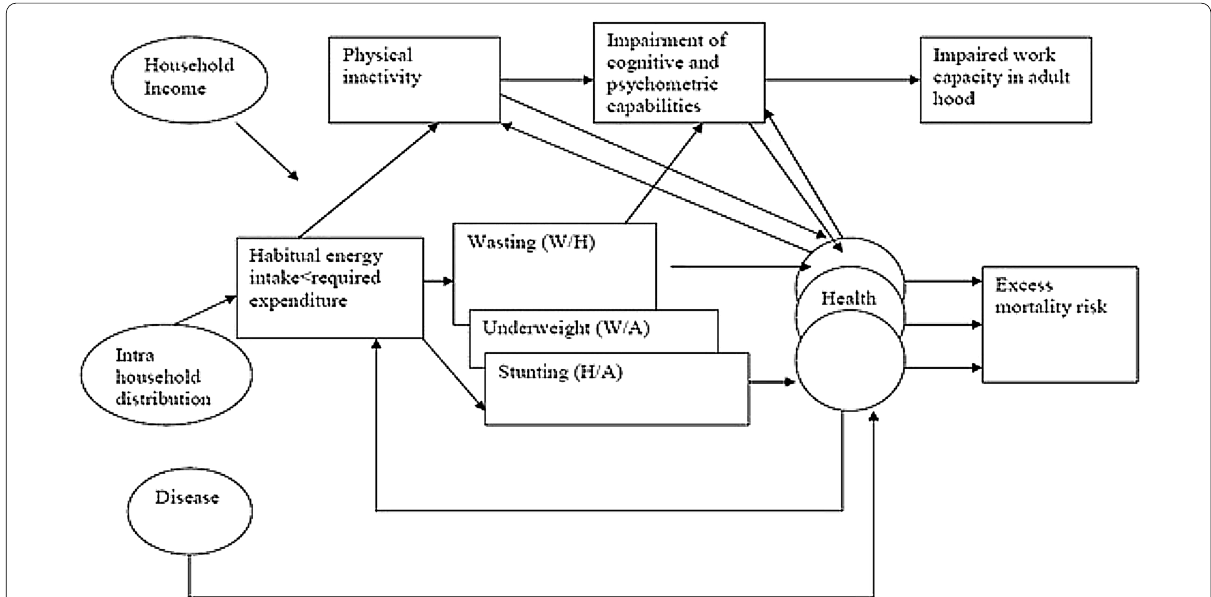
Fig. 1 Causes, Symptoms and Consequences of Under nutrition Source : Peter Svedberg (2000), poverty and under nutrition: Theory, Measurement and